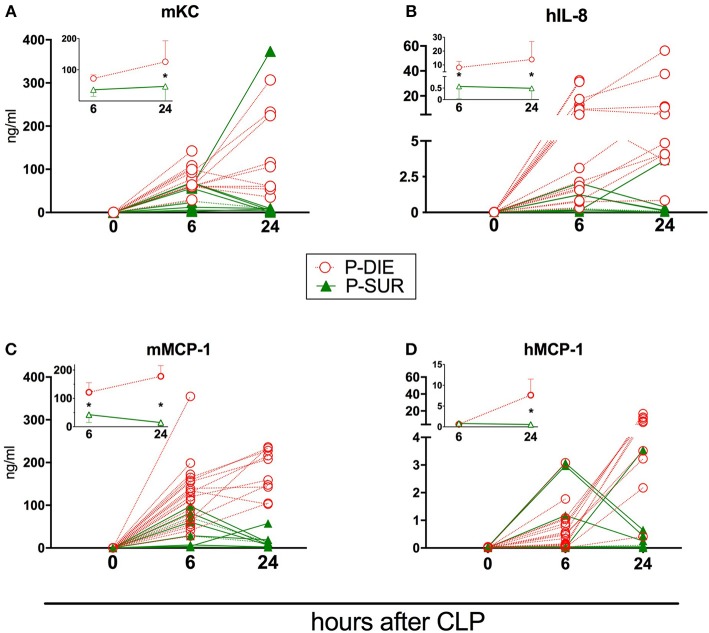
Comparison of human and murine chemokines depending on the post-CLP outcome in humanized mice. Insets present data as mean values and 95% confidence interval bars. (A) murine KC; (B) human IL-8; (C) murine MCP-1; (D) human MCP-1. (P-DIE n = 22, P-SUR n = 9). Concentrations of chemokines between P-SUR and P-DIE mice were compared by the t-test at each time-point separately. *p < 0.05.